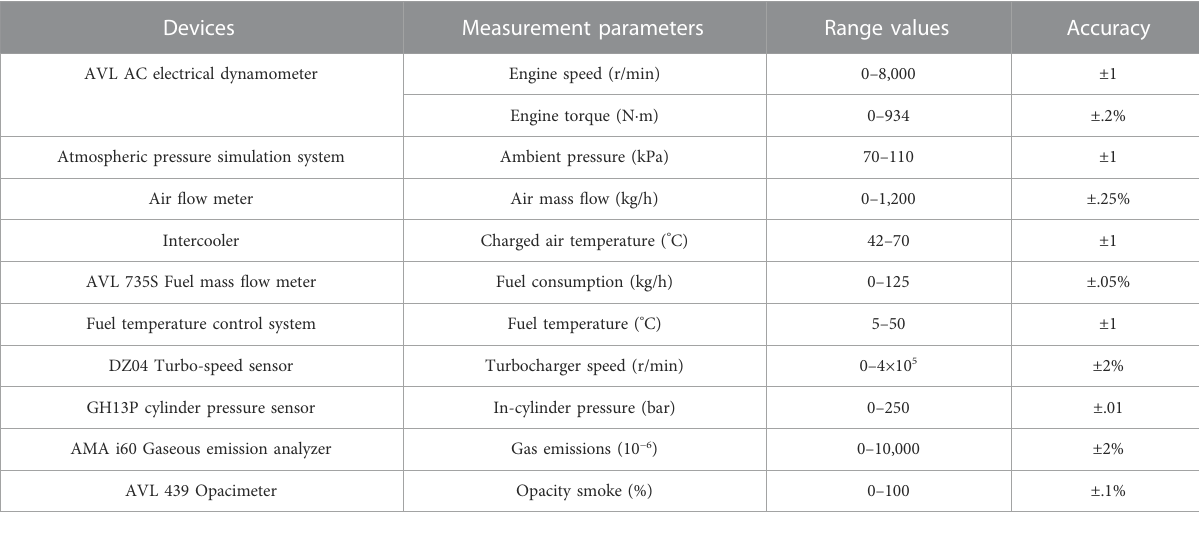
TABLE 2 Parameters of main experimental devices.